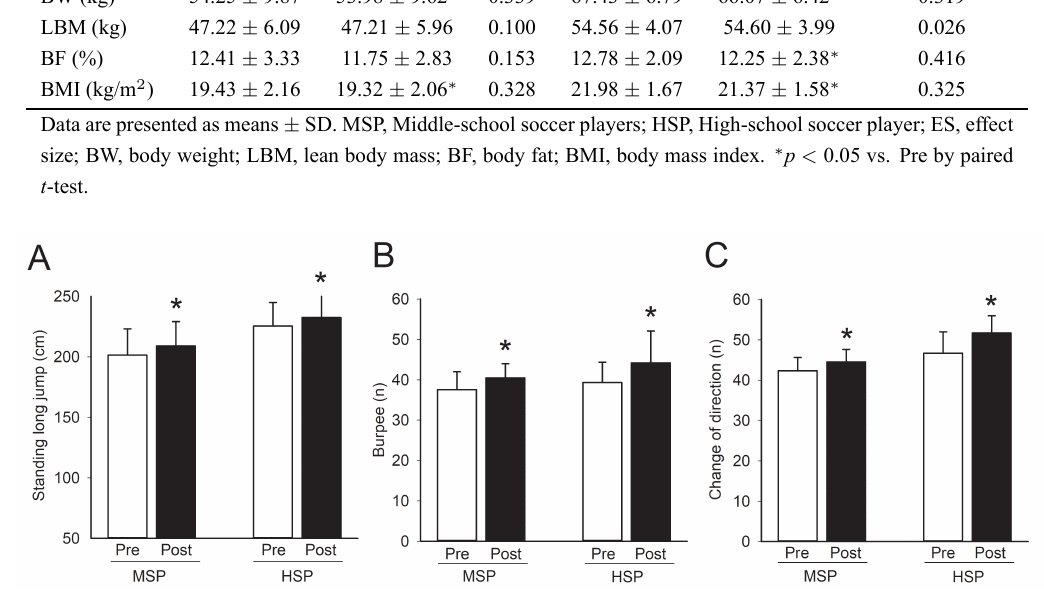
Fig. 2. Effects of 2-weeks off-season training on physical fitness in Korean male middle- and high-school soccer players. Standing long jump (A), Burpee’s (B), change of direction (C) in MSP and HSP. Data are presented as means ± SD. * p < 0.05 vs. Pre by paired t -test. MSP, Middle-school soccer players; HSP, High-school soccer